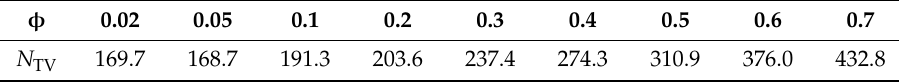
Figure 9. Relative number of topology violations as a function of polymer volume fraction in the good solvent with A ps = − 40. The reference number of topology violation is for the dilute limit. The inset shows the distribution of the α angle between 170° and 180° for the topology violation events in the concentrated solution ( φ = 0.7) during a total simulation time of t = 5000 τ . Table 2. Average number of topology violations per 100 τ for in semidilute solutions with different polymer volume fractions. The results are obtained in simulations having a total time of t = 5000 τ